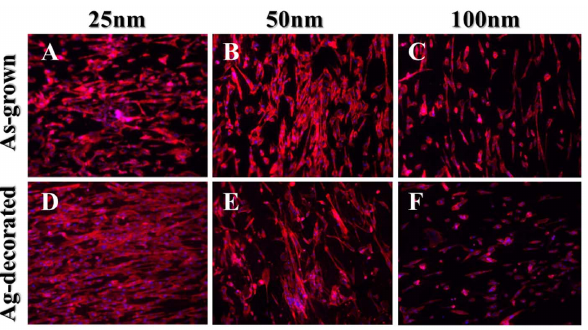
Figure 8. Fluorescence images of the human fibroblast cells attached on the as-grown (A–C) and Ag-decorated (D–F) TiO 2 nanotubes of different diameters. The red fluorescence indicates cytoskeletal actin, and the blue fluorescence indicates cell nuclei. For both as-grown and Ag-decorated TiO 2 nanotubes, longer, better- defined actin cytoskeleton, and higher density of fibroblasts were noted on the smaller diameter